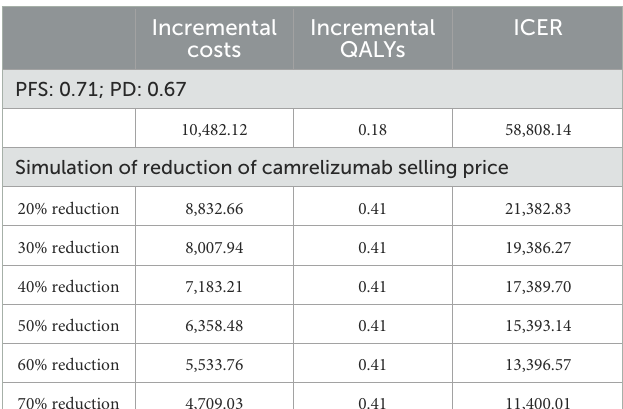
TABLE 5 Cost-effectiveness of treatment of camrelizumab + chemotherapy vs. chemotherapy in scenario